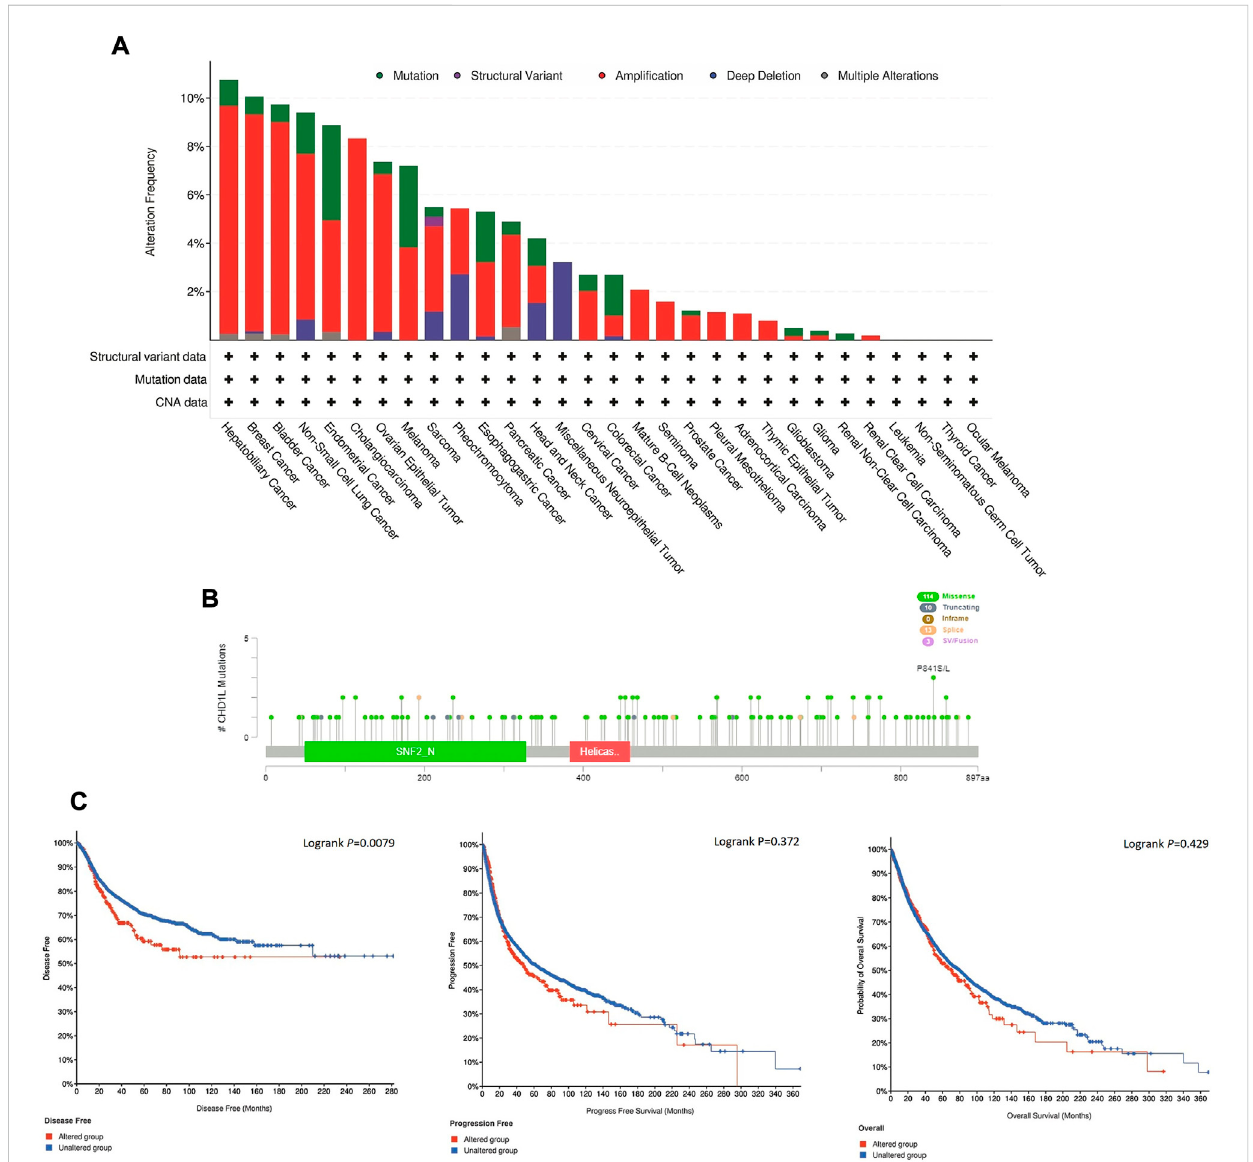
FIGURE 5 MutationassessmentforCHD1LusingthecBioPortal tool. (A) Thealterationfrequencywithmutationtypeinapanelofanalyzedhumancancers. (B) AmaprepresentationforsitesandtypesofCHD1Lmutations. (C) AssessmentofthecorrelationbetweenCHD1Lmutationanddisease-free,progression- free, and overall